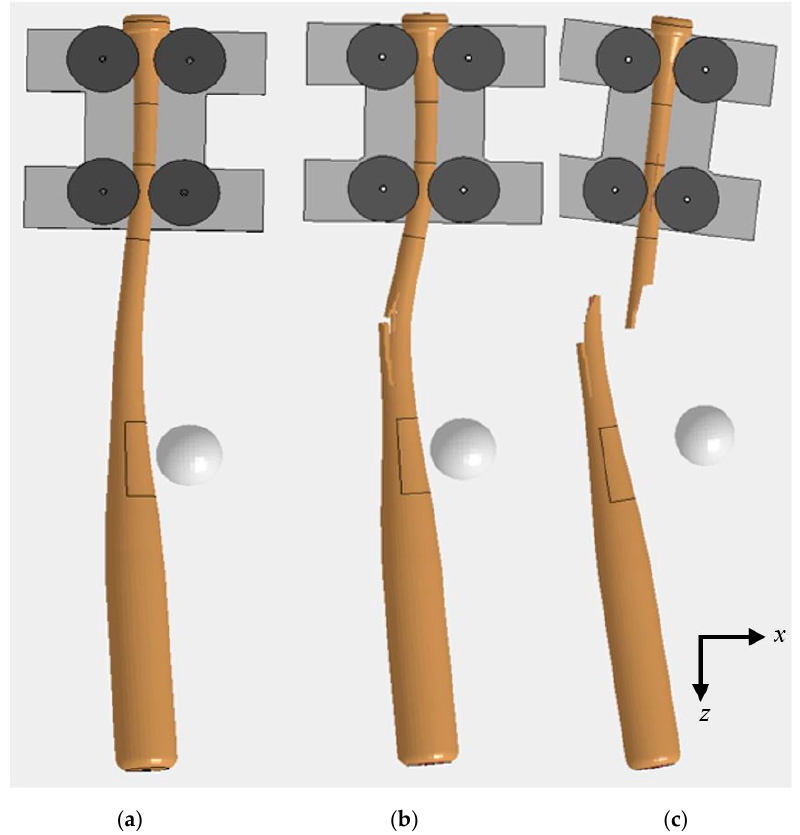
Figure 7. Bat failure modes ( a ) No Failure (NF), ( b ) Single-Piece Failure (SPF), and ( c ) Multi-Piece Failure (MPF).